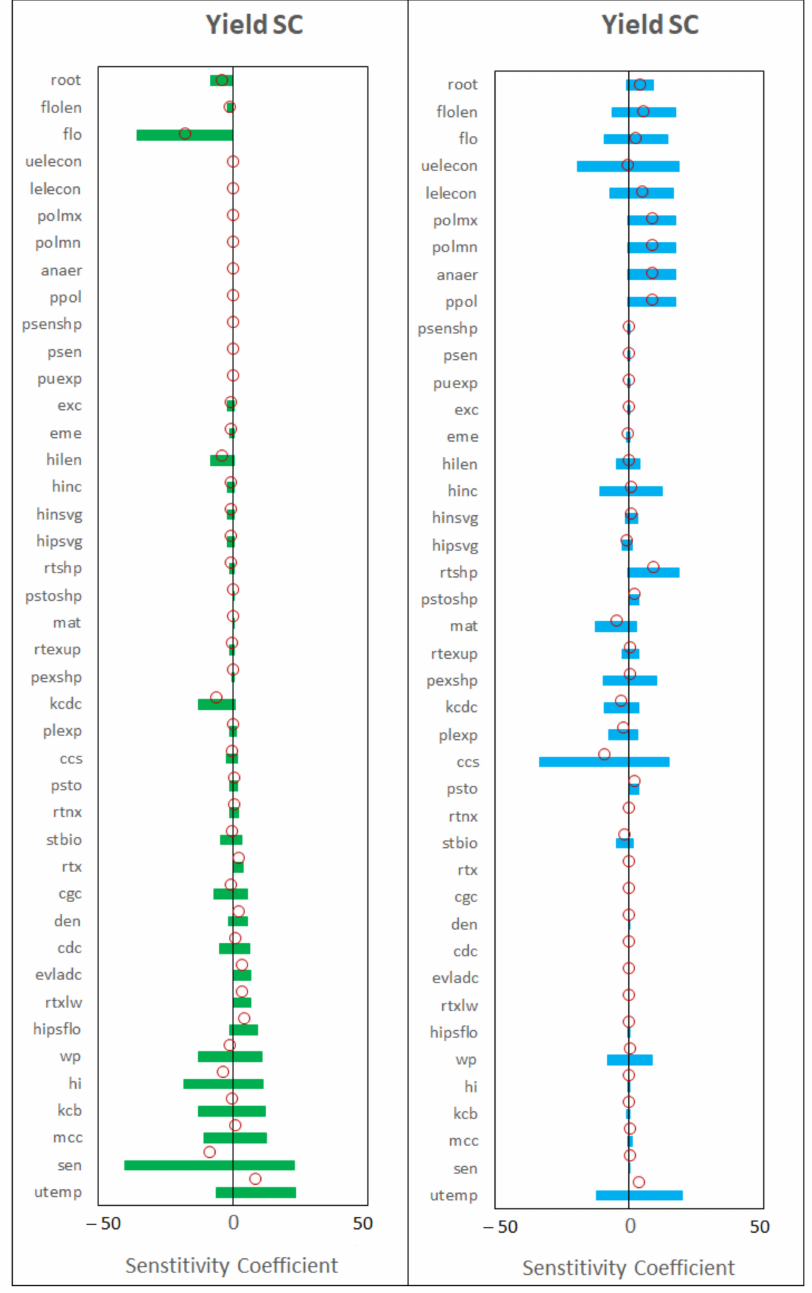
Figure 3. Sensitivity coefficients (SC) for corresponding yield (Y SC) or evapotranspiration (ET SC) change along with ± 1% change in selected crop parameters. i.e., red circles show average values for Y-SC and ET-SC for each crop